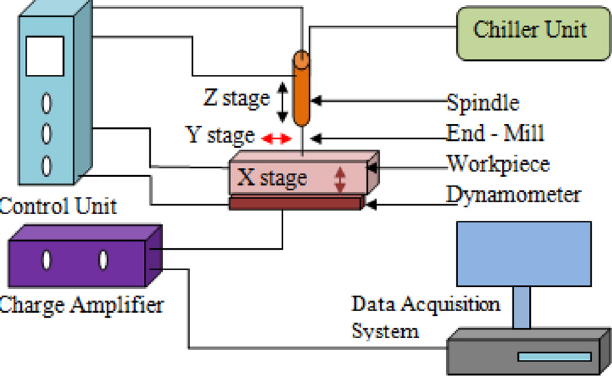
Fig. 8. Schematic representation of high speed micro end milling